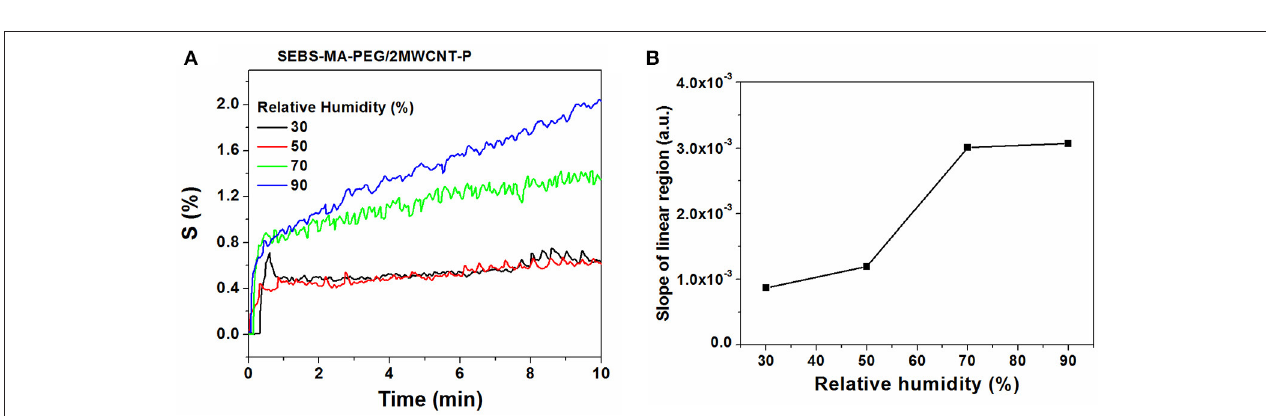
FIGURE 9 | (A) Response of 0.1mm thick SEBS-MA-PEG/2MWCNT-P samples exposed to various humidities and (B) the corresponding slopes of changes of S in ∼ the linear region at the beginning of the response curves.